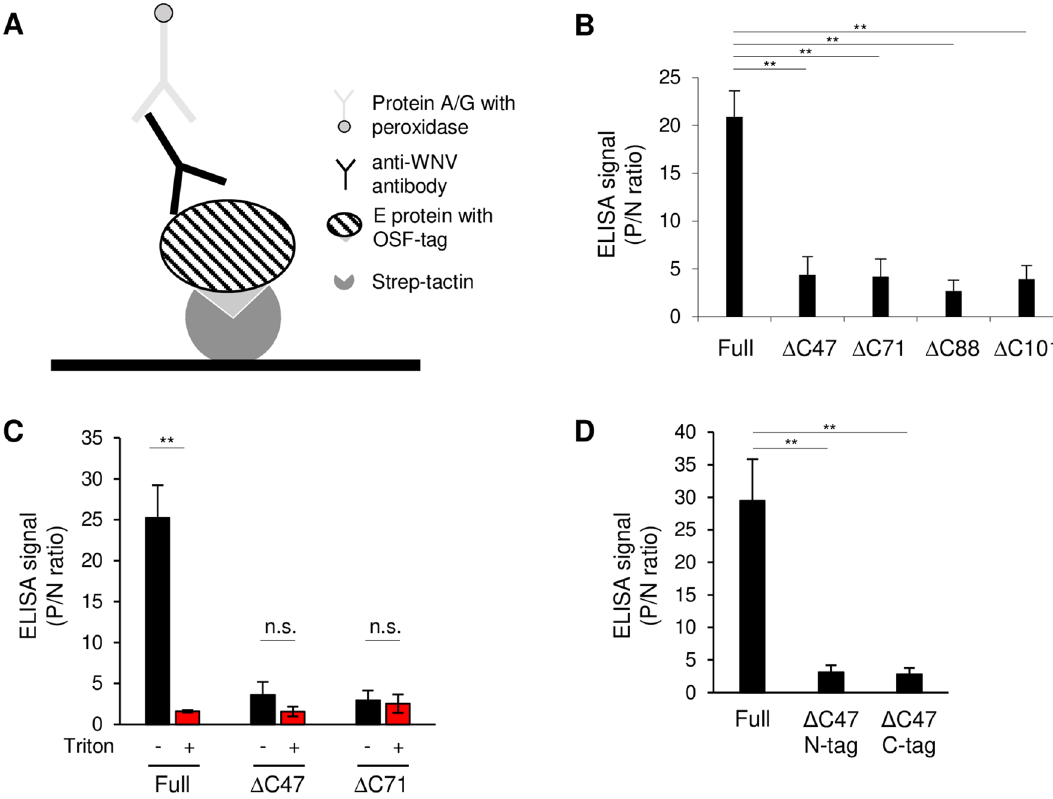
Figure 2. Development of an ELISA for the serodiagnosis of WNV infection. ( A ) Schematic of the developed ELISA using E proteins with an OSF tag. The E protein with an OSF tag is trapped by a Strep-Tactin coating. Anti-WNV IgG in WNV-infected mouse serum reacts with the E protein and is detected by protein A/G conjugated with HRP. ( B ) Comparison of E proteins as antigens for ELISA. The results were recorded as P/N ratio (OD value of E protein relative to that of the negative control antigen). Data are presented as the mean ± standard error of three independent experiments. Statistical significance was evaluated using one-way ANOVA followed by the Tukey–Kramer test. (**p < 0.01). ( C ) Comparison of reactivity with and without Triton X-100. The supernatant from transfected 293 T cells was treated with (red) or without (black) 1% Triton X-100 and used as the antigen in an ELISA. The results were recorded as P/N ratio. Data are presented as the mean ± standard error of three independent experiments. Statistical significance was evaluated using a two- tailed Student’s t-test (**p < 0.01). ( D ) The ELISA signal using full-length (Full), ∆C47 with OSF tag at the N-terminus (∆C47 N-tag) or C-terminus (∆C47 C-tag) of E protein. The results were recorded as P/N ratio (OD value of E protein relative to that of the negative control antigen). Data are presented as the mean ± standard error of three independent experiments. Statistical significance was evaluated using one-way ANOVA followed by the Scheffe’s F test (**p <